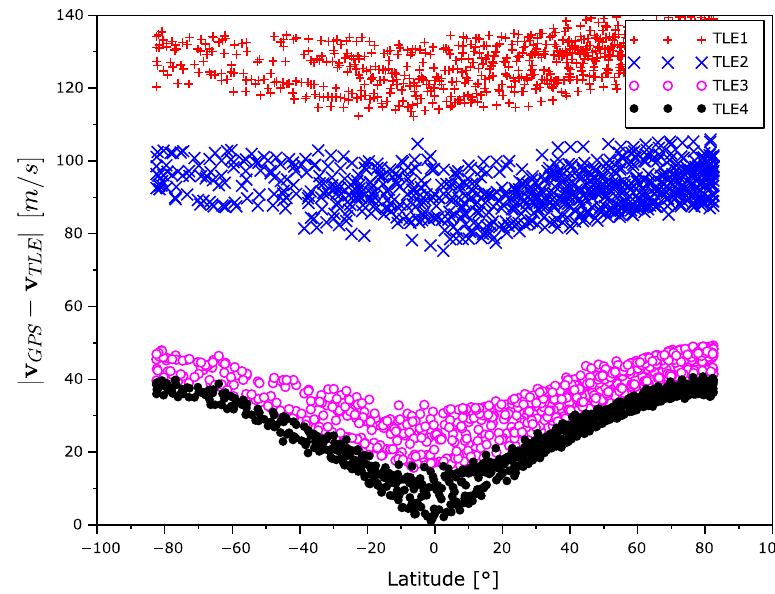
Figure 14. Velocity error magnitude as a function of latitude.